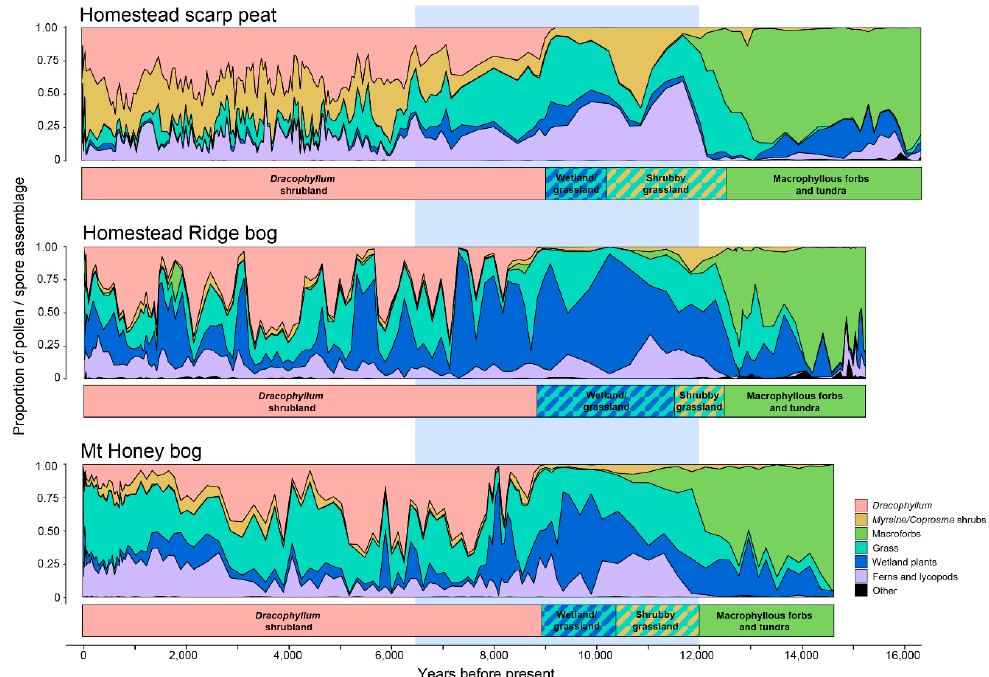
Figure 3. Summary percentage pollen and spore diagrams for Homestead Scarp Peat (HSP), Homestead Ridge Bog (HRB), and Mount Honey Bog (MHB). Blue vertical shading represents the period during the Holocene (12,000 to 6500 BP) when the tree line was repressed.